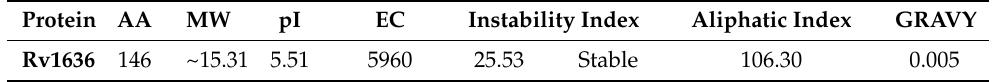
Table 1. Physiochemical profile of Rv1636 protein.